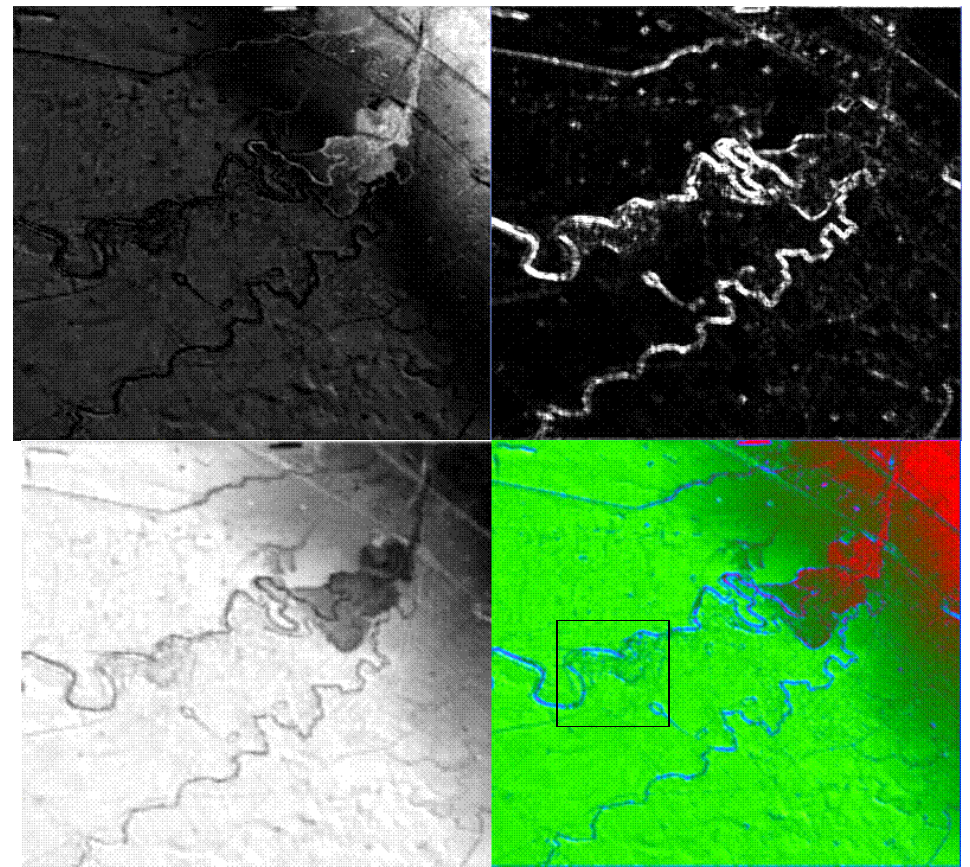
Fig. 5. Results from spatial autocorrelation statistics, maps from Moran index (upper left), Geary’s (upper left), Getis (lower left) and RGB of all the three indices (upper right).